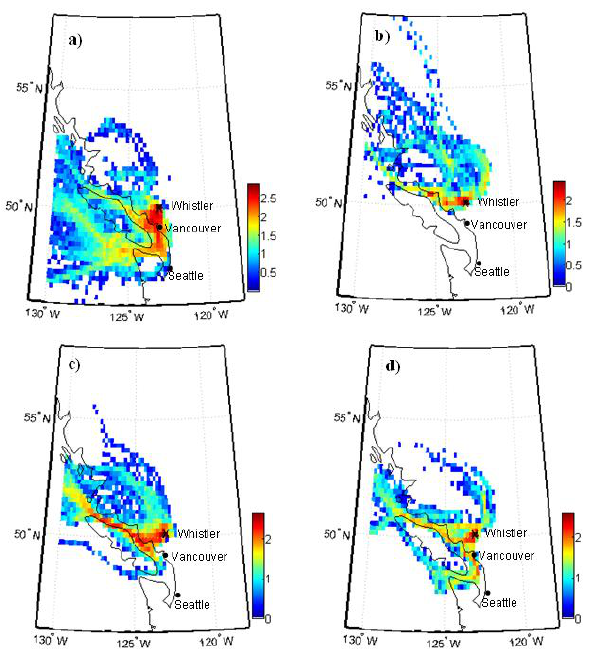
Fig. 1. HYSPLIT back trajectory (72 h) analysis for trajectories ini- Fig. 1 . HYSPLIT back trajectory (72 hours) analysis for trajectories initiated at Whistler, with 993 tiated at Whistler, with meteorological data sets from the Eta Data meteorological data sets from the Eta Data Assimilation System (EDAS) for (a) period 1, (b) 994 Assimilation System (EDAS) for (a) period 1, (b) period 2, (c) pe- period 2, (c) period 3, and (d) period 4. The color scale indicates log 10 of the number of 995 riod 3, and (d) period 4. The color scale indicates log 10 of the num- trajectories that have passed through a certain grid cell. The grid cells are 0.2 degrees wide in 996 ber of trajectories that have passed through a certain grid cell. The both latitudinal and longitudinal direction. For every day 24 back trajectories have been 997 calculated with an interval of one hour between each trajectory. 998 grid cells are 0.2 degrees wide in both latitudinal and longitudinal 999 direction. For every day, 24 back trajectories have been calculated with an interval of one hour between each